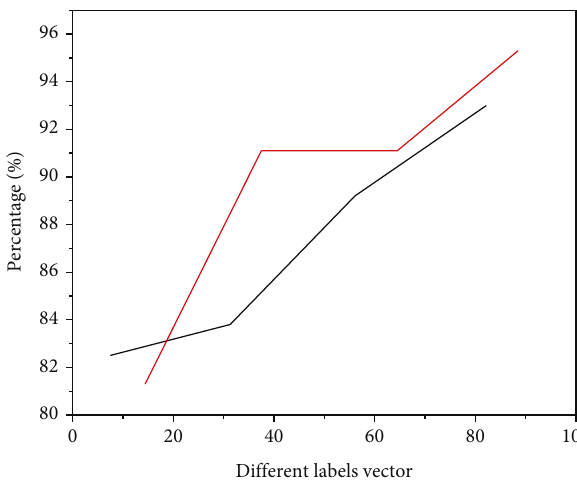
Figure 4: Comparison of extraction e ff ects of di ff erent label vectors.